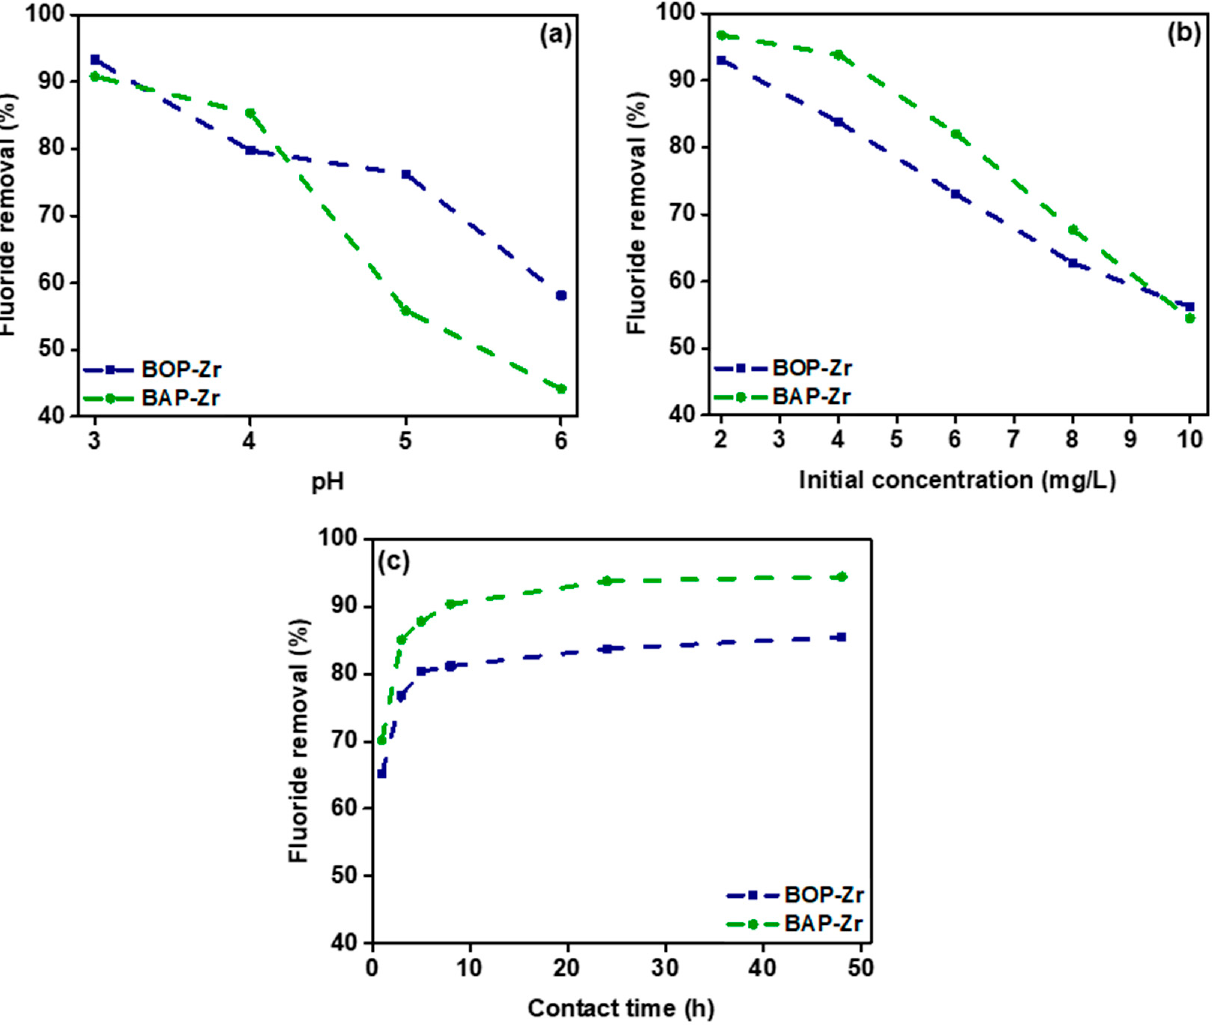
Figure 6. Efficiency of the fluoride removal by the bioadsorbents in function of: ( a ) pH; ( b ) the initial concentration, mg/L; and ( c ) contact time, h.